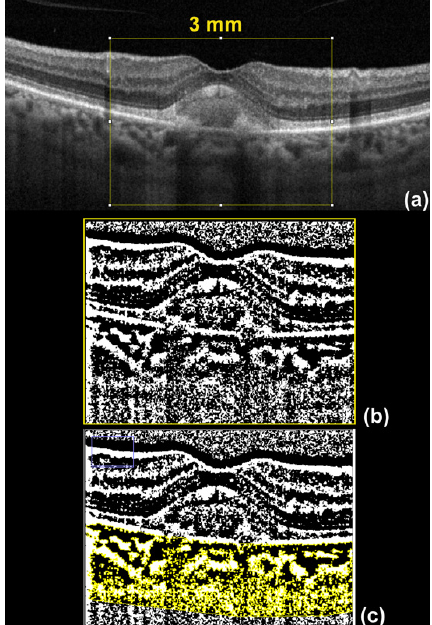
Figure 2. Choroidal vascularity index processing. ( a ) A rectangle centered on the foveal region of 3 mm was selected, and then cropped for further analysis; ( b ) The image obtained was binarized using auto local threshold with Niblack method. ( c ) A polygonal region of interest was traced to delimitate the choroidal area used to calculate the choroidal vascularity index.